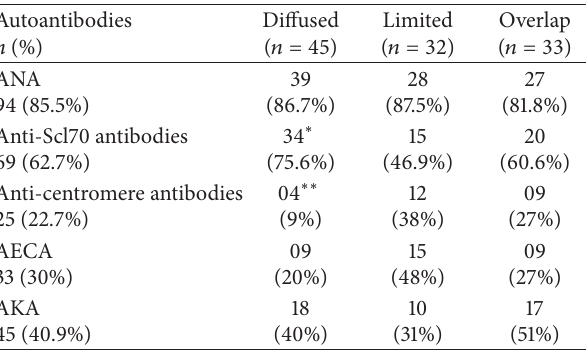
Table2:Distributionofautoantibodiesinsubgroupsofscleroderma patients ( 𝑛 = 110